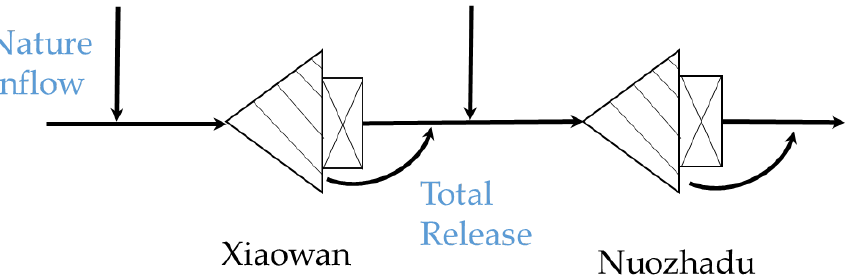
Table 1. Characteristics of hydropower plants.